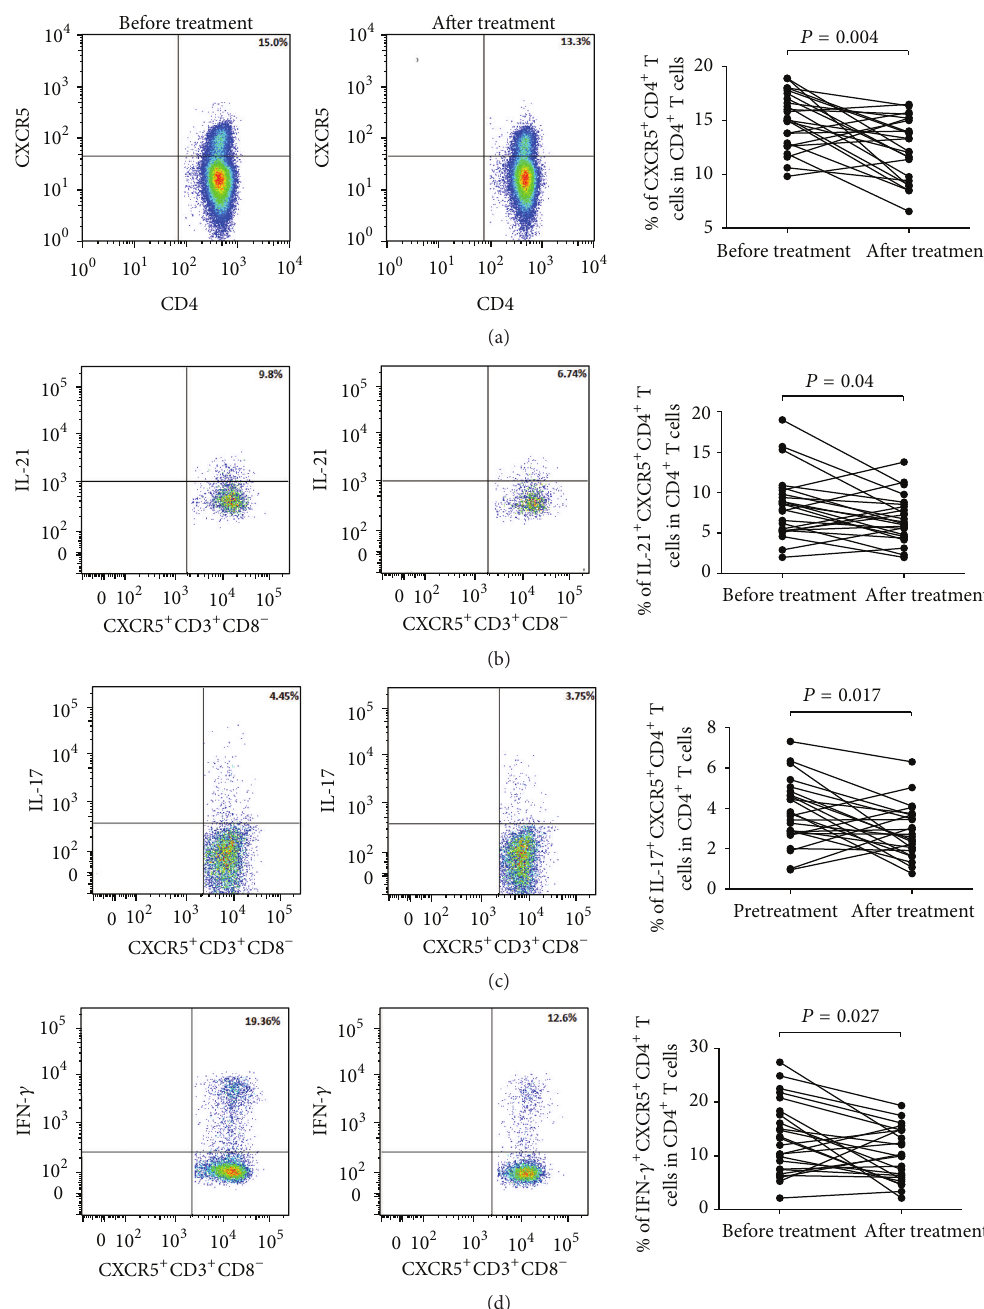
Figure 5: The frequency and cytokine production of cTfh cells before and after treatment. (a) After 1-month treatment, with alleviation of disease severity, the frequency of cTfh cells is significantly decreased in psoriasis patients. (b, c, and d) The levels of IL-21, IL-17, and IFN- 𝛾 produced by cTfh are all lower than those before treatment. P values are